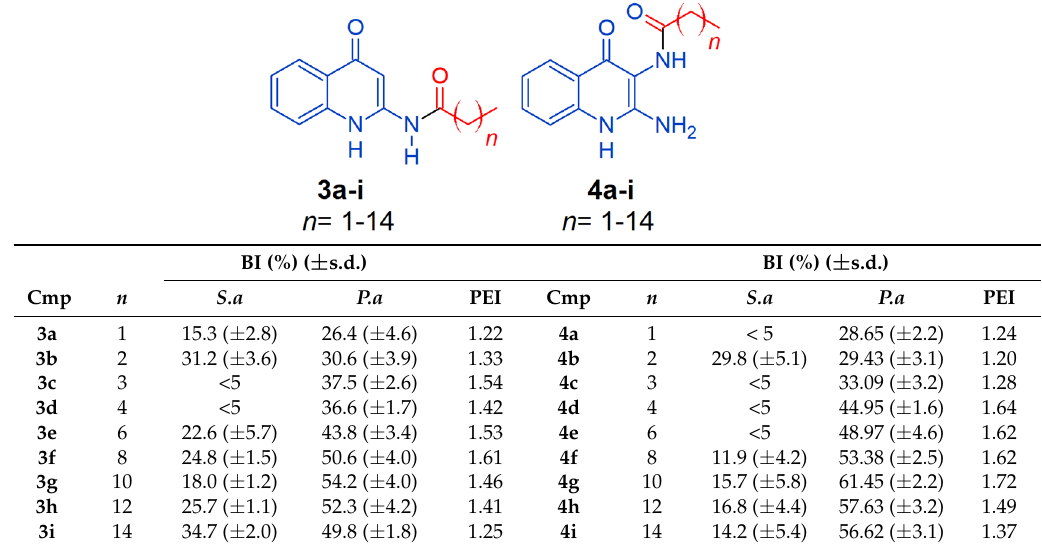
Table 1. Biofilm inhibition (at 20 µ M) of compounds 3a-i and 4a-i in S. aureus and P. aeruginosa studies.